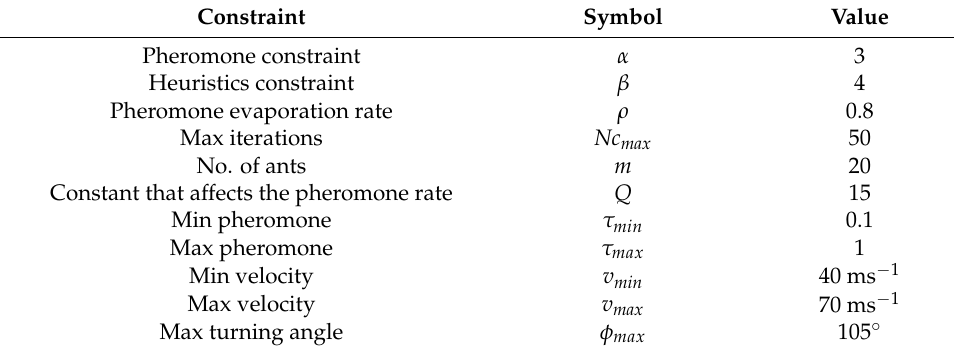
Table 1. Constraints for the